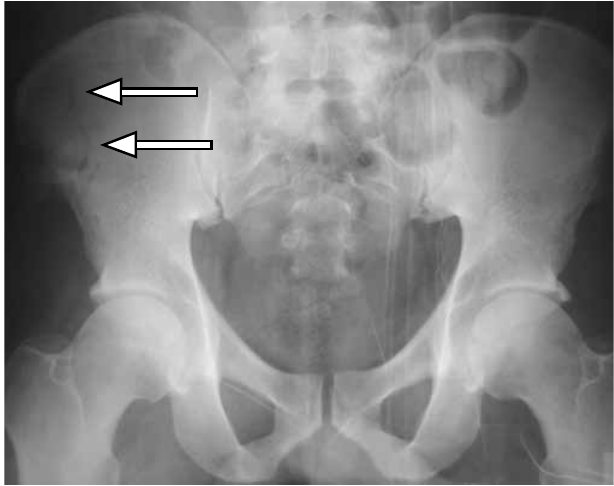
Fig. 1. X-ray of the pelvis showing fracture (arrows) of the right ilium in patient 1.